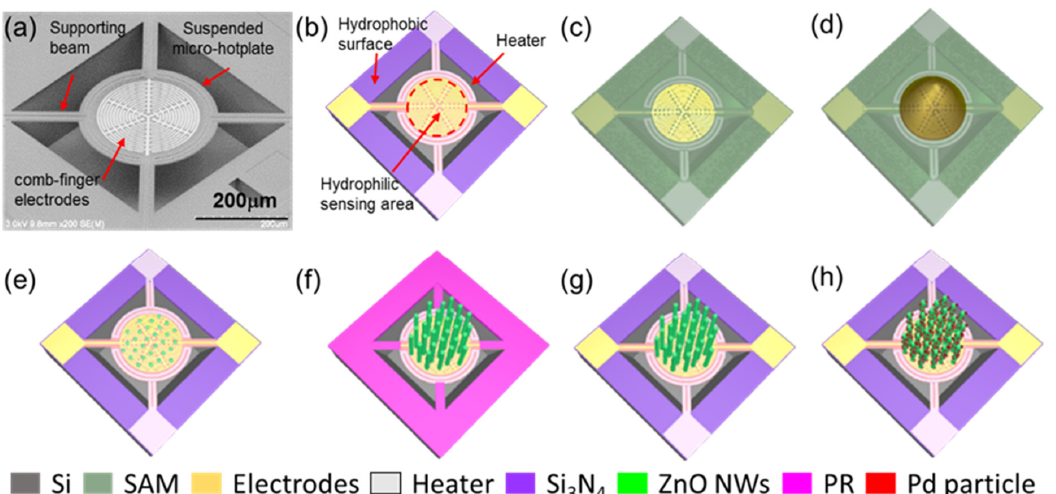
Figure 1. ( a ) SEM image of micro ‐ hotplate and the structure of the sensor. ( b ) Design of micro ‐ hot ‐ plate sensor. The sensing area of the hotplate, which is surrounded by the Pt heaters, is hydrophilic, while other parts of the chip are hydrophobic. ( c – h ) Process steps of in ‐ situ growth of Pd ‐ modified ZnO NWs on the